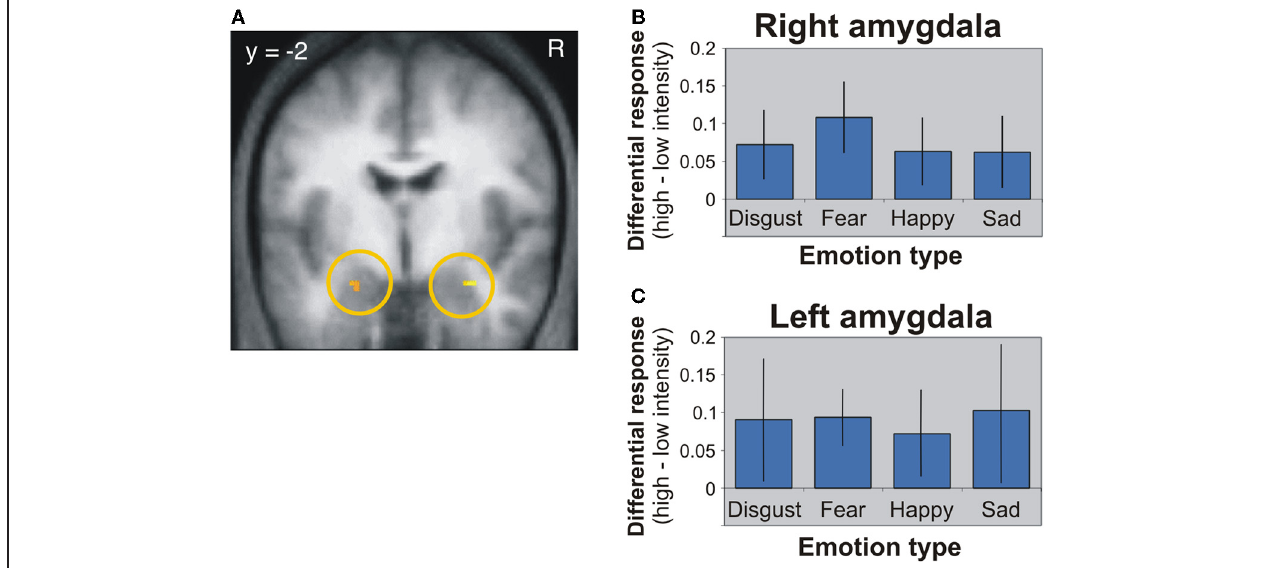
FIGURE 1 | Amygdala activation in response to different facial expressions (Winston et al., 2003). (A) Activation image of the amygdala during the processing of high-intensity expressions compared to